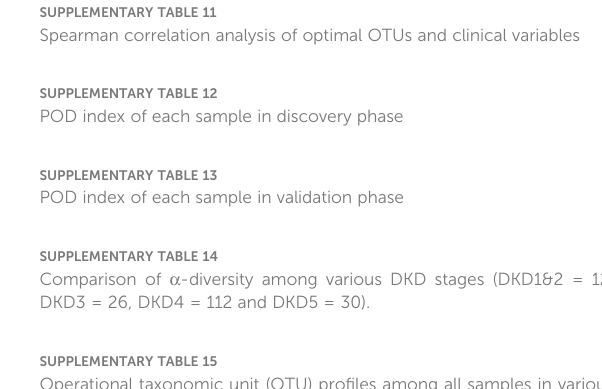
SUPPLEMENTARY TABLE 11 Spearman correlation analysis of optimal OTUs and clinical variables